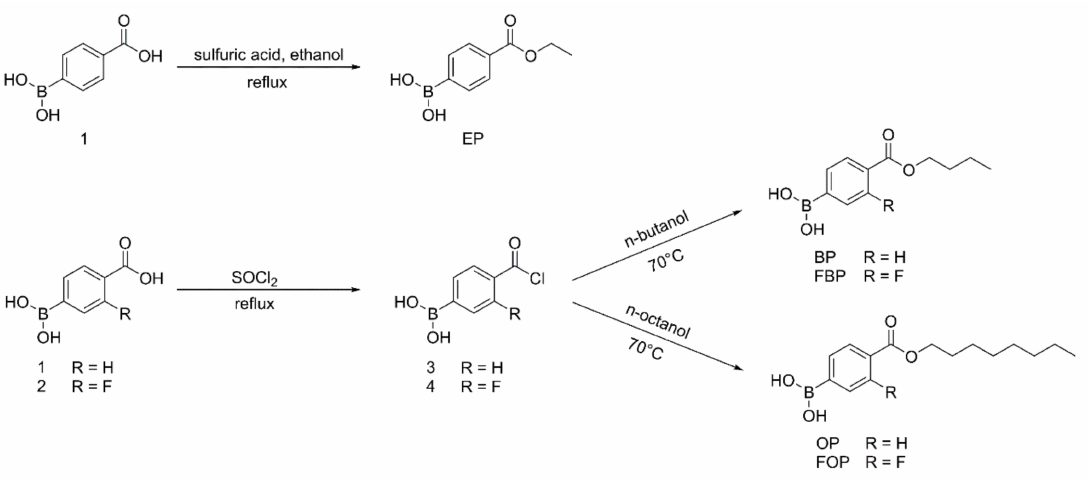
Figure 2. Synthetic routes of compounds EP, BP, FBP, OP, and FOP.